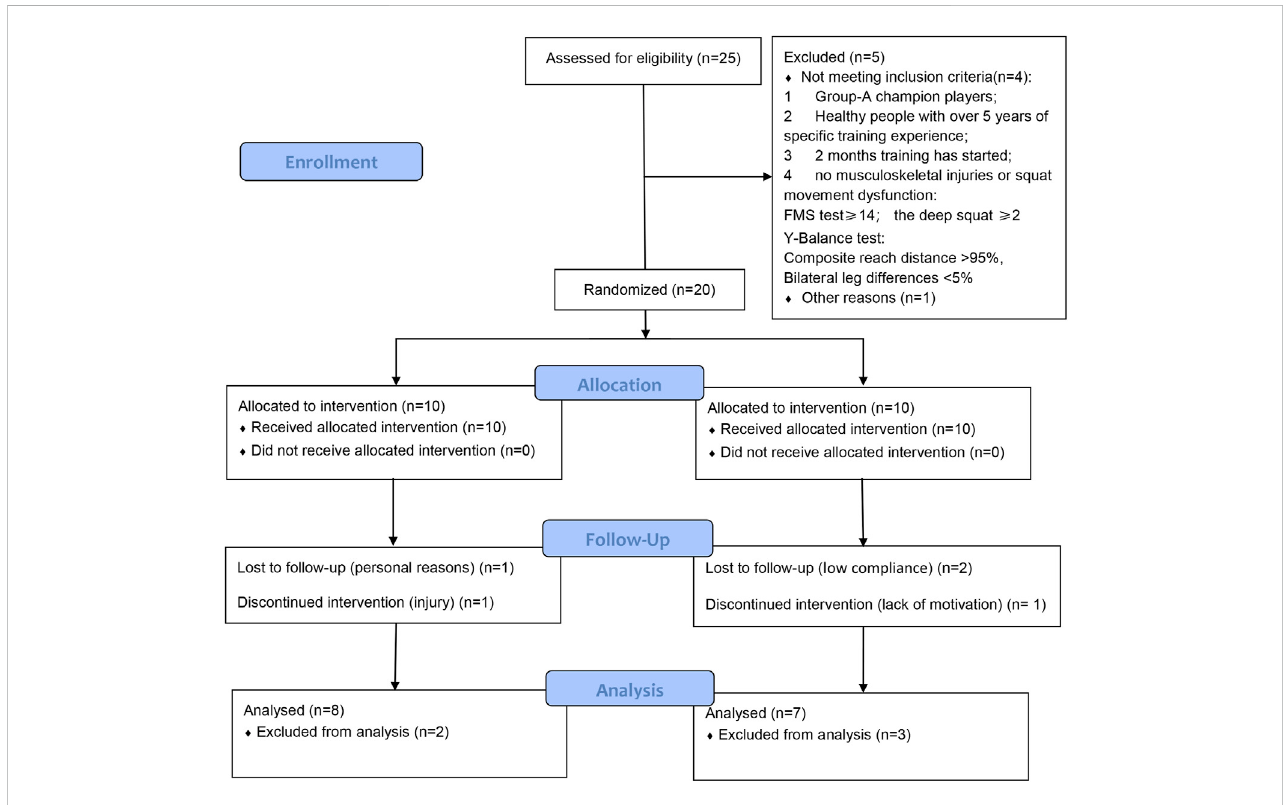
FIGURE 1 Flowchart for screening, recruitment, allocation, intervention, and